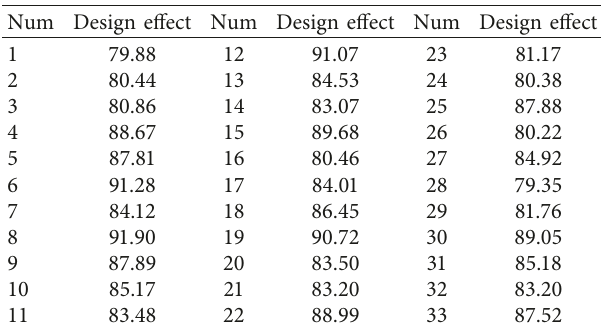
Table 1: Design effects of virtual products.